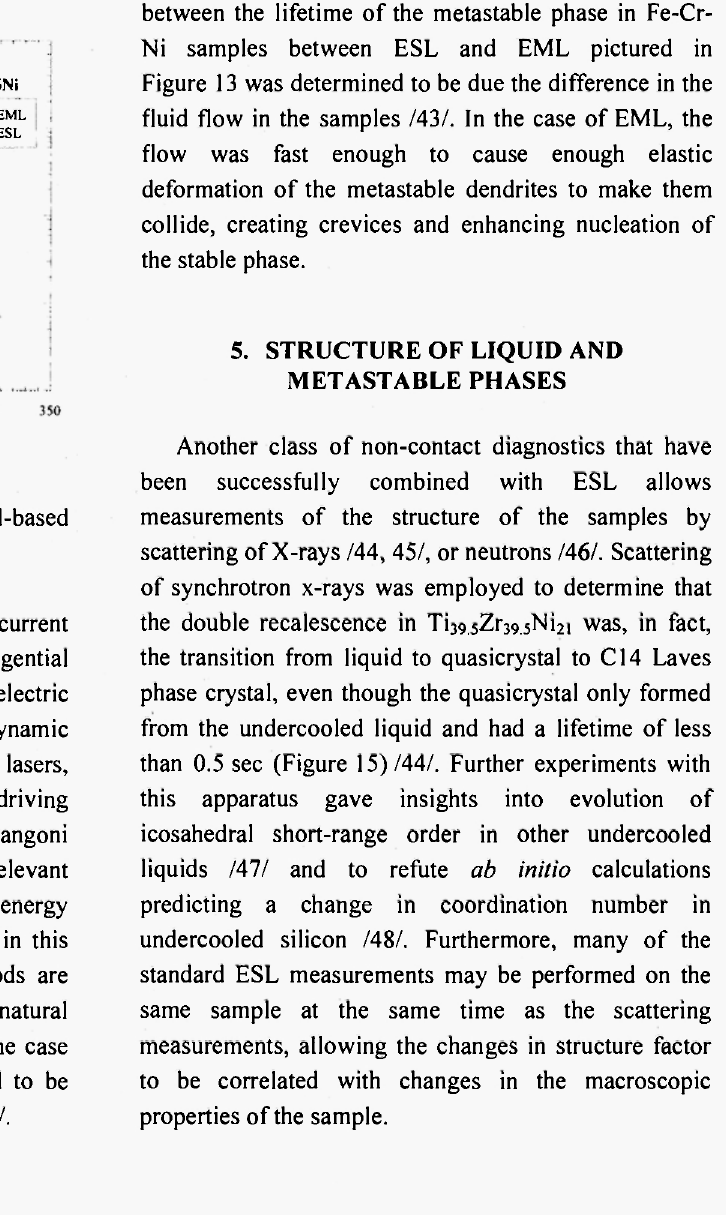
Fig. 13: Comparison of delay times for ground-based EML and ESL testing.